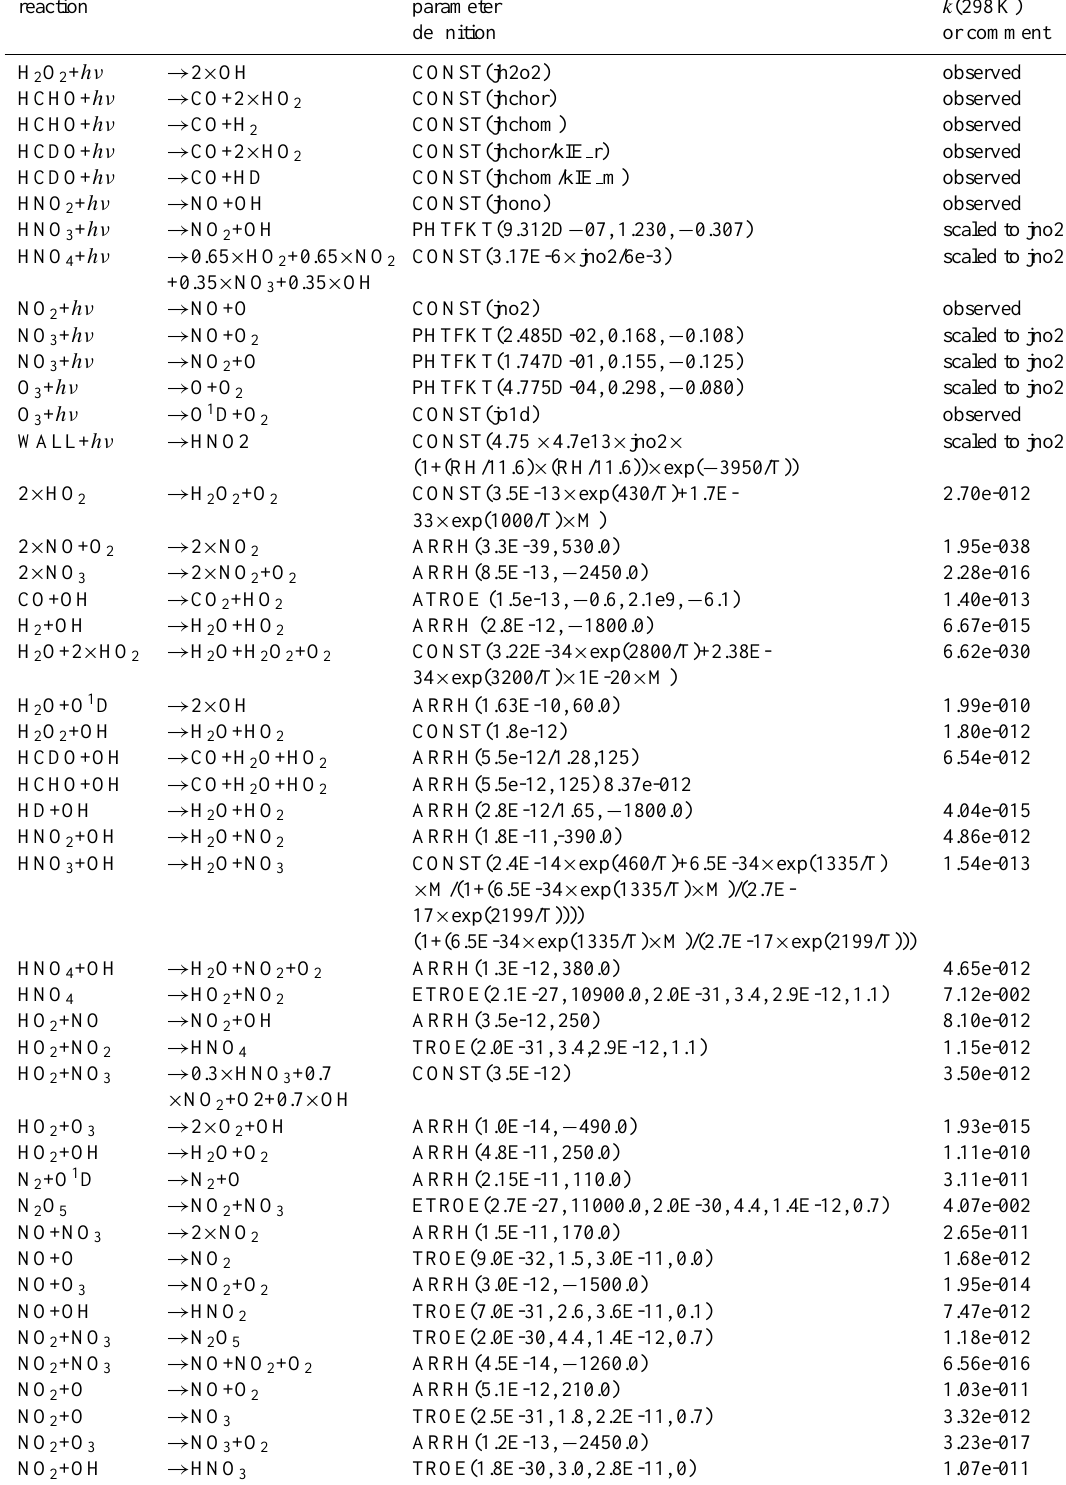
Table A1. List of reactions included in the SAPHIR photochemical model. Rate coefficients are from (Sander et al.,